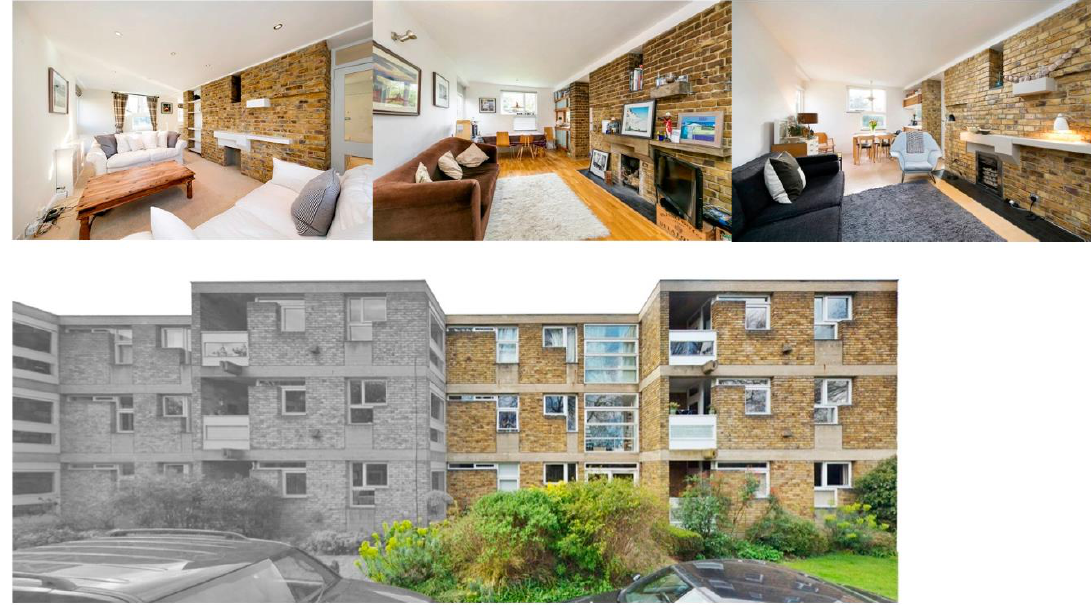
Figure 8. Pictures of the flat with a gas-fireplace and a wood-fireplace ( above ) and a picture of the external part of the building with the analyzed part ( below ).